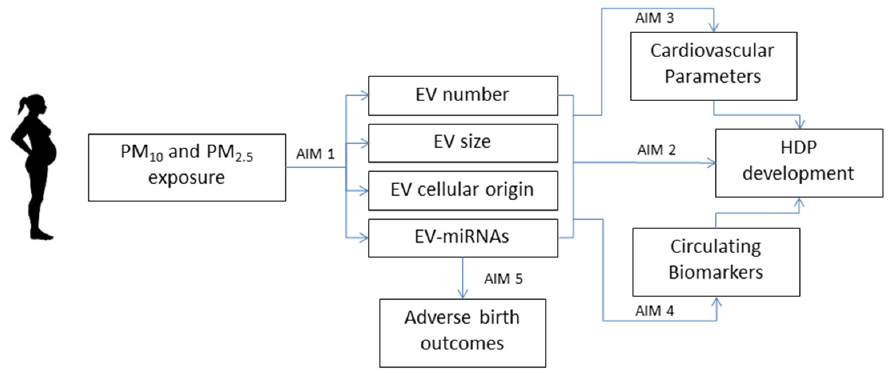
Figure 2. Specific aims of the INSIDE project. HDP: Hypertensive Disorders in Pegrnancy.